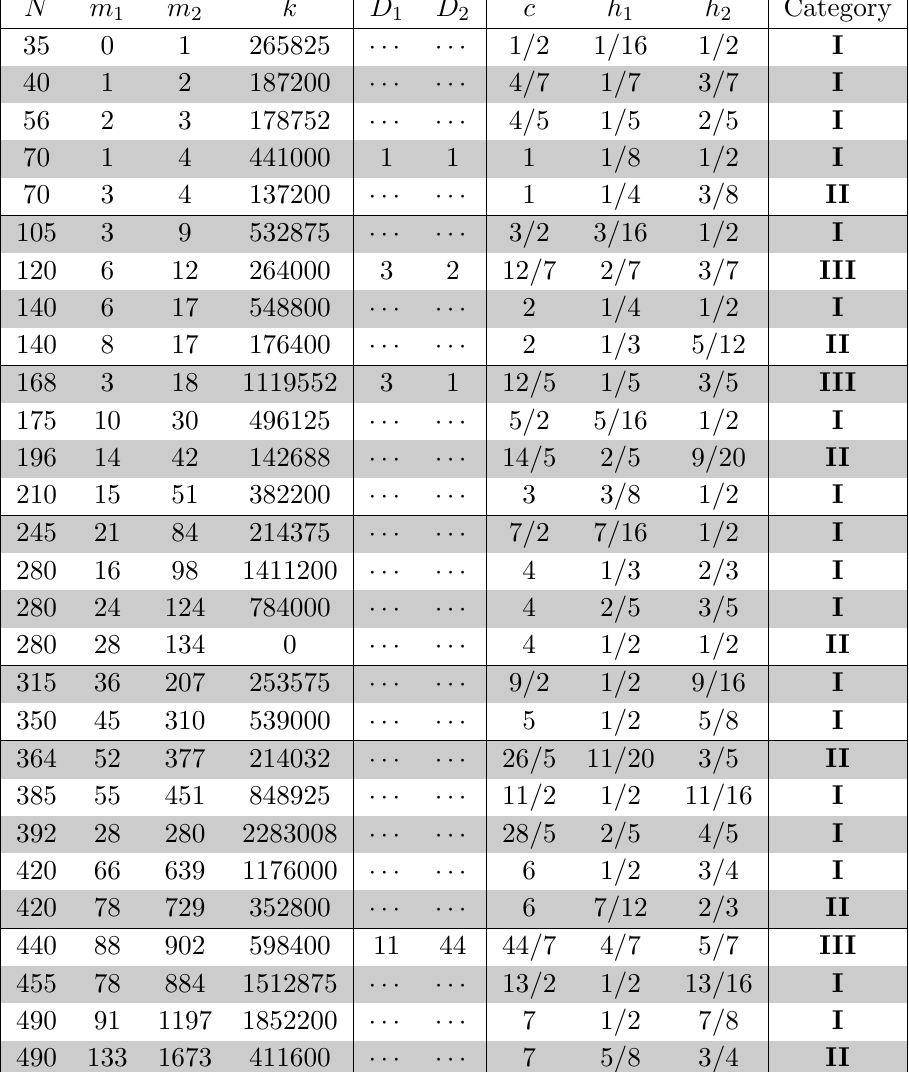
Table 11 . Solutions to the [ 3 , 0 ] MLDE with 0 < c ≤ 7